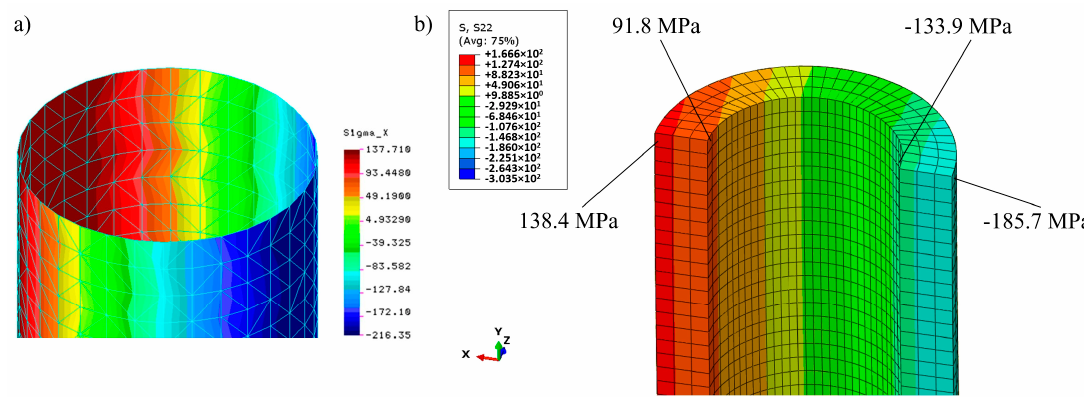
Figure 9. Distribution of the longitudinal stresses at the middle section of the original column (nonlinear analysis): ( a ) Outer surface N = 115 kN (COSMOS/M system); ( b ) distribution along the = 117 kN (Simulia Abaqus system). wall thickness N = 117 kN ( Simulia Abaqus system). wall thickness N